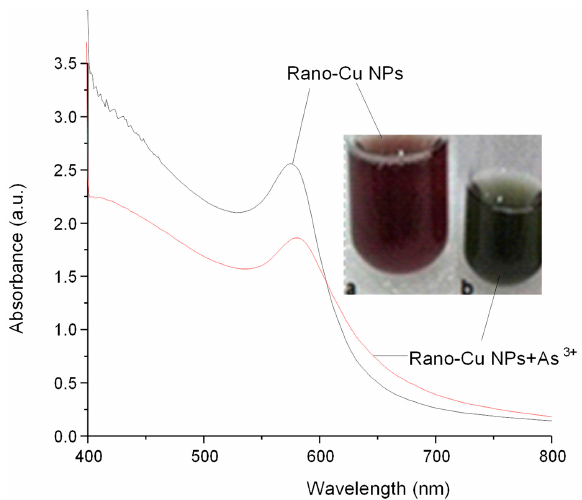
Figure 3. UV-Vis spectra for Rano-Cu NPs (black curve) and the interaction of Rano-Cu NPs with As 3+ (red curve with 5 min reaction time). Inset shows color change according to UV-Vis spectral results.